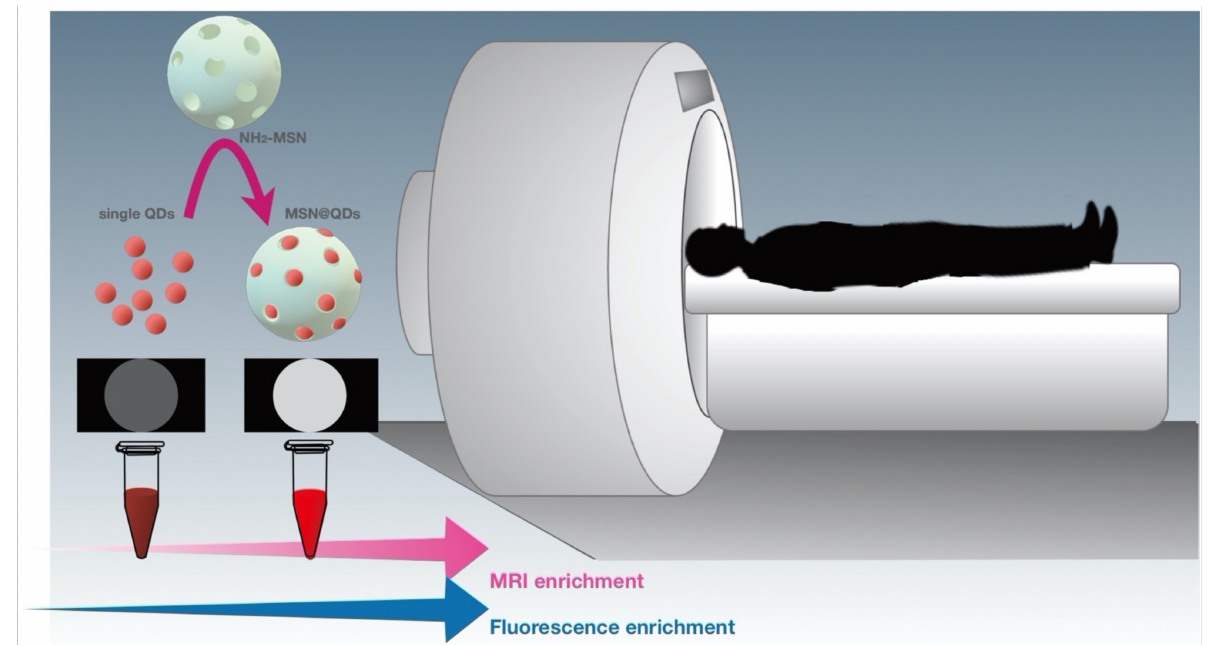
Figure 6. MSNs as a dual imaging probe in bioimaging. Schematic illustration of MSNs as a dual-imaging probe to synergistically enhance MRI and fluorescence in bioimaging